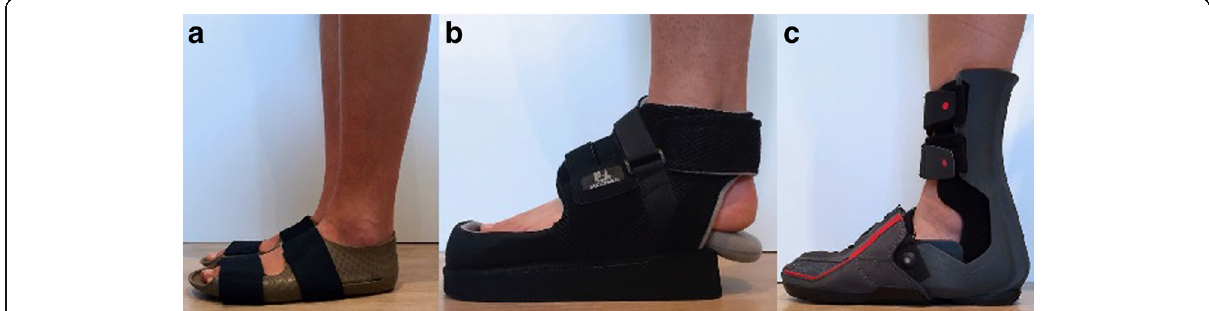
Fig. 2 a : Illustration of the neutral shoes that were used to assess the reference values for dynamic pedobarography (Fuss und Schuh Breidbach® Inc., Fulda, Germany). b : Illustration of Hindfoot relief shoe (HRS) (München, Fior and Gentz Inc., Lueneburg, Germany®) and c : Illustration of Hindfoot relief orthosis (HRO) ( “ Dr. Settner/Münch ” , Otto Bock Health Care Germany GmbH